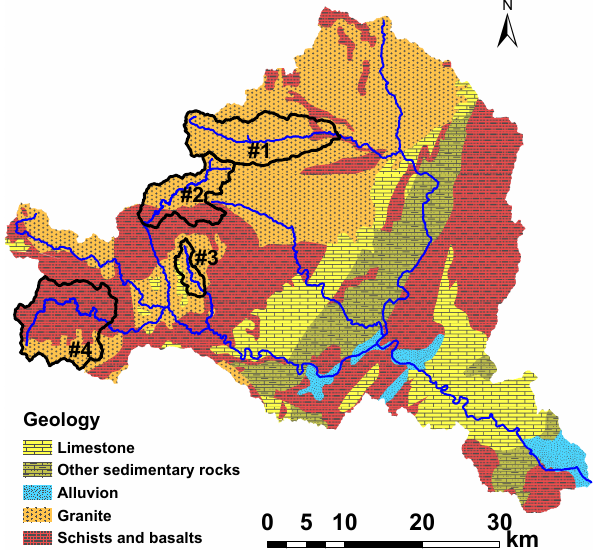
Figure 2. Geological map of the Ardèche catchment (extracted and processed from geological map of France 1 : 1000000 issued by BRGM (6th edition,